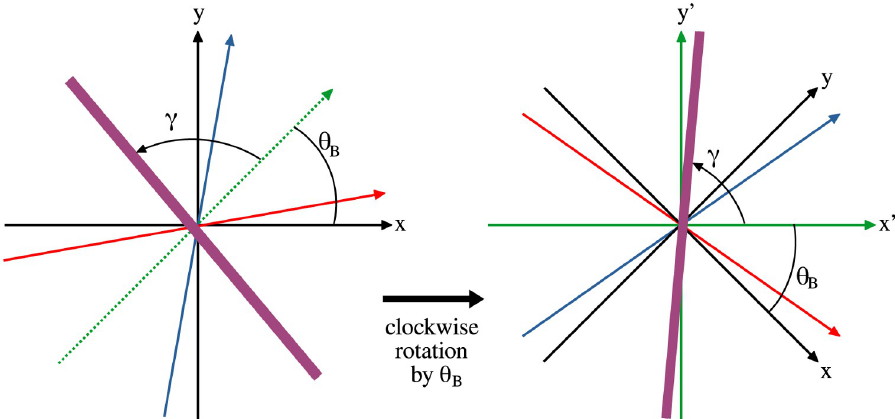
Fig 18. Transformation of coordinates. This diagram schematically represents the transformation given to the experimentally obtained data such that the transformed x -axis, i.e., x 0 is along the bisector of the two group direction vectors. The arrows in blue and red indicate the two group direction vectors and the dotted green arrow indicates the bisector. θ B is the angle between the bisector and the original x -axis. A clockwise rotation by an angle θ B in this case makes the bisector as the new x -axis. The transformed axes x 0 and y 0 are shown by green arrows. The bold line in purple represents a stripe, which makes an angle γ (measured anti-clockwise) with the bisector of group direction or the x 0 -axis. The purpose of the pattern matching technique is to find out the orientation of stripes γ